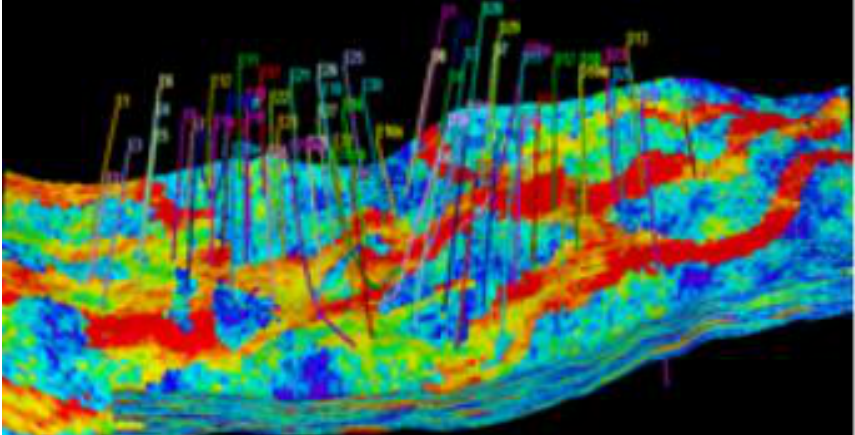
Figure 3—Example with multiple wells drilled in the North Malay